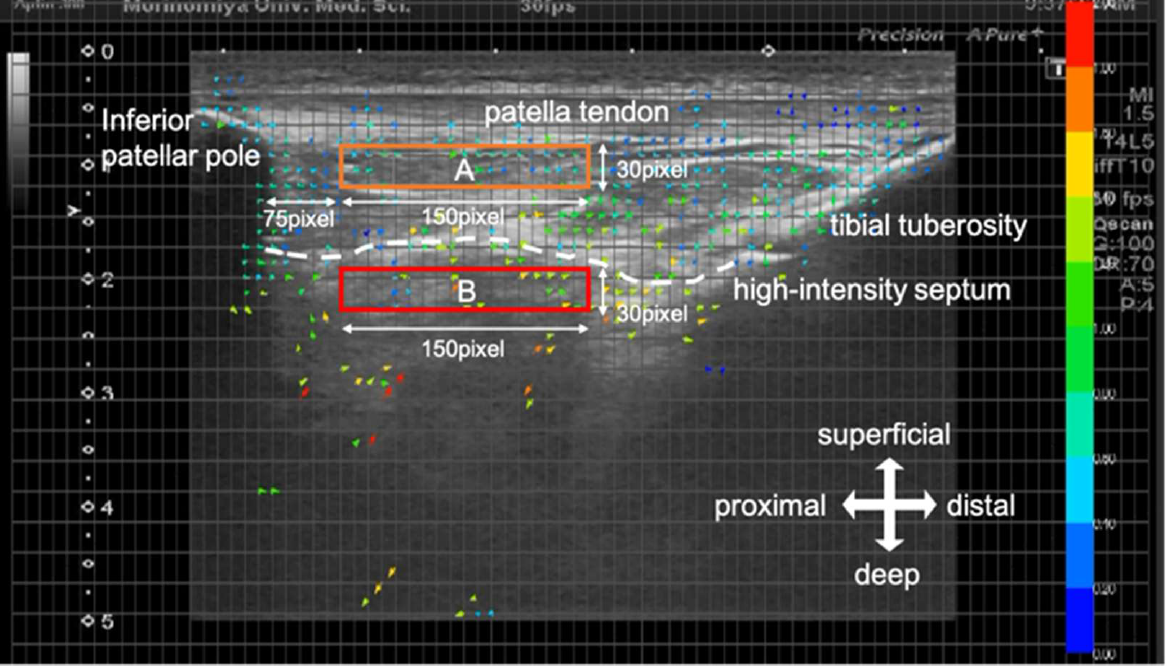
Figure 2. Ultrasound image using flow particle image velocimetry. Based on an ultrasonogram movie image, 2 regions of interest were placed on the IFP superficial part and IFP deep part. ( A ) superficial part. ( B ) deep part.